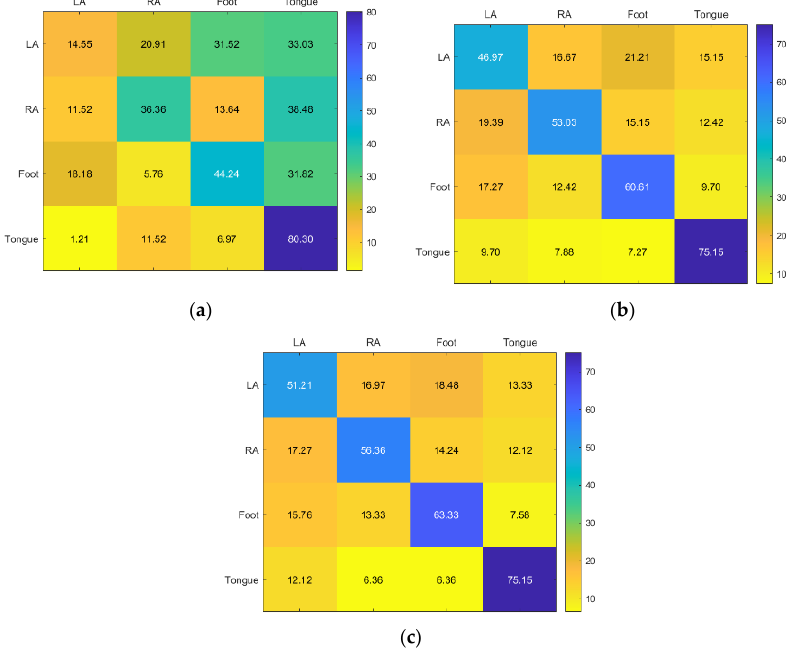
Figure 13. Confusion matrices for the ( a ) KNN, ( b ) SVM, and ( c ) RF classifiers to demonstrate the MI-BCI performance from the seventh subject ’ s four classes (left hand, right hand, feet, and tongue). KNN has generally good accuracy with foot and tongue for Subject 8. SVM only has good accuracy in foot, whereas RF also achieves acceptable results (Figure 14).